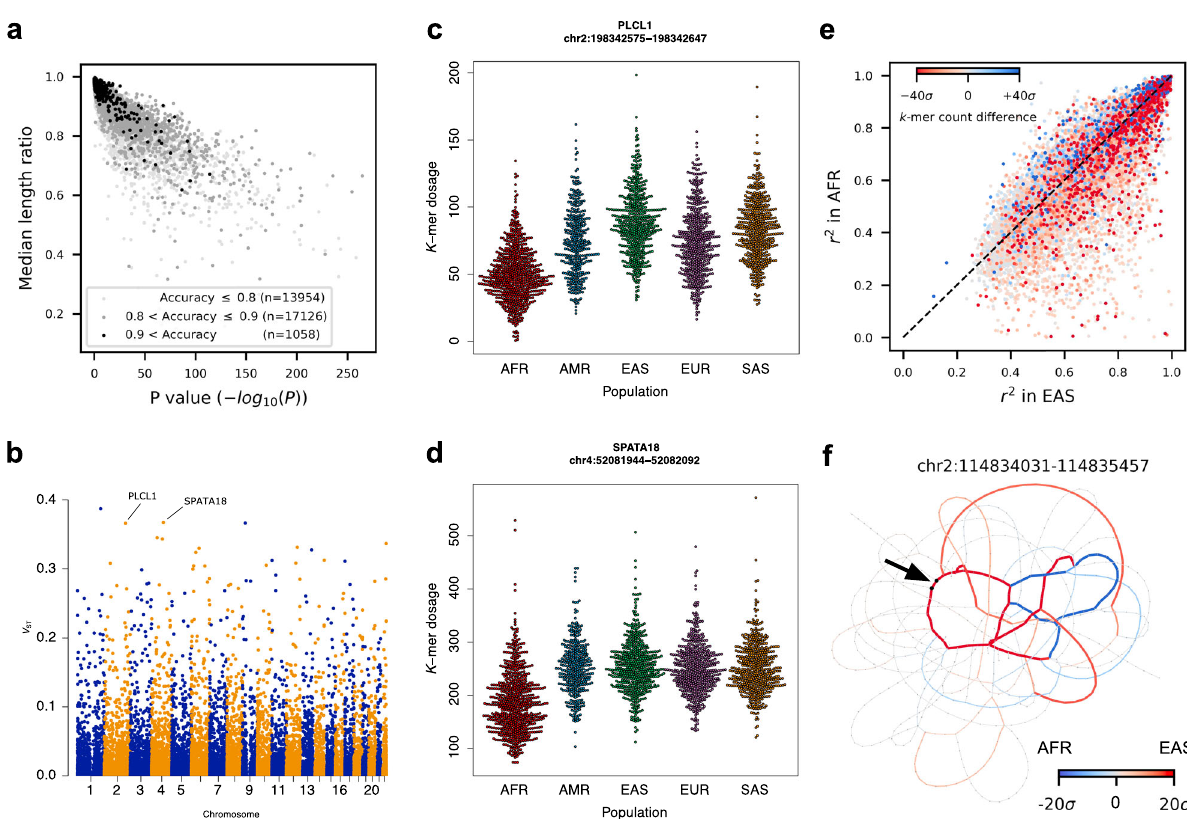
Fig. 4 Population properties of VNTR loci. a Ratios of median length between populations for loci with signi fi cant differences in average length. Loci are strati fi ed by accuracy prediction (<0.8), medium (0.8 – 0.9), and high (0.9 + ). b Manhattan plot of V ST values. c , d The distribution of estimated length via k - mer dosage in continental populations for PLCL1 and SPATA18 VNTR loci, selected to visualize the distribution of dosage in different populations. Each point is an individual. e Differential usage and expansion of motifs between the EAS and AFR populations. For each locus, the proportion of variance explained by the most informative k -mer in the EAS is shown for the EAS and AFR populations on the x - and y -axes, respectively. Points are colored by the difference in normalized k -mer counts, with red and blue indicating k -mers more abundant in EAS and AFR populations, respectively. f An example VNTR with differential motif usage. Edges are colored if the k -mer count is biased toward a certain population. The black arrow indicates the location of the k -mer that explains the most variance of VNTR length in the EAS population. Source data are provided as a Source Data fi